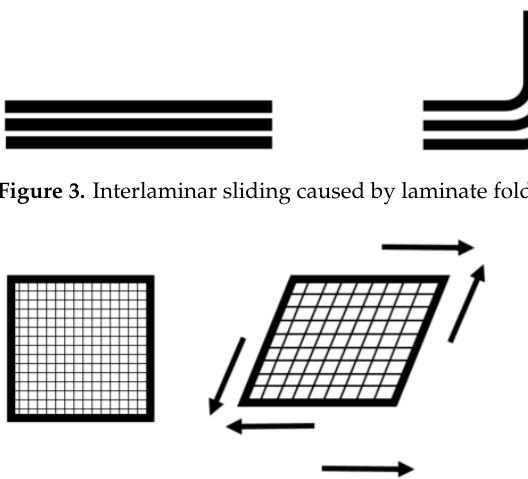
Figure 4. Shear deformation of the layers with different fiber orientations.